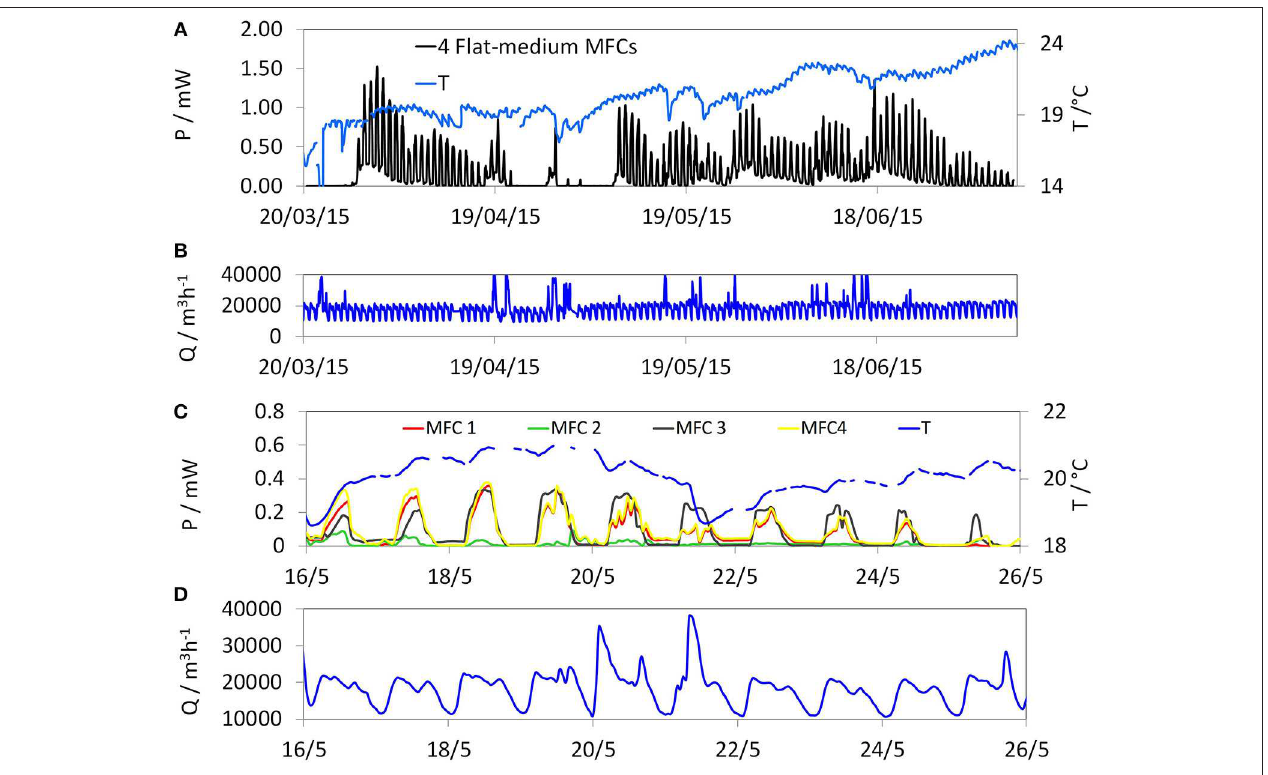
FIGURE 4 | Power trends of the Flat-medium MFCs (18 × 18cm) operated from April to July 2017 (Milano-Nosedo WWTP) (A) ; trends of temperature and wastewater flow incoming in the plant (B) ; zoomed view of the power trends at daily scale (C) ; zoomed view of temperature and wastewater flow at daily scale (D)